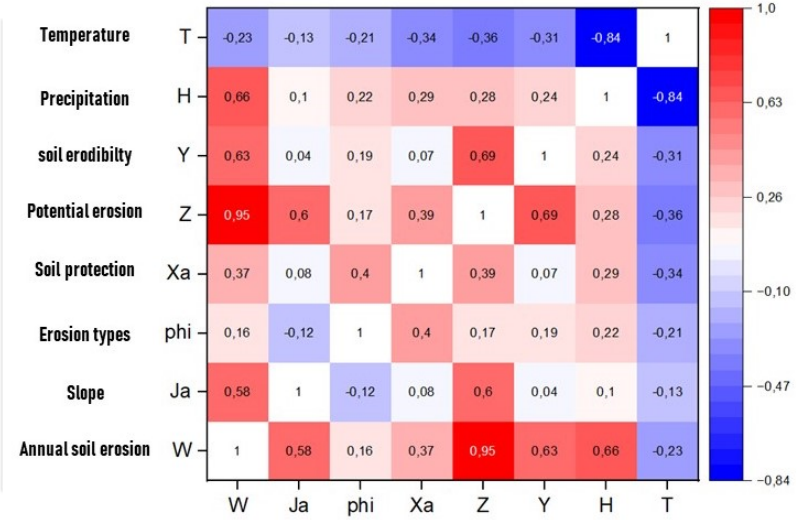
Figure 4. Pairwise Pearson’s correlation between soil erosion rate and input factors.